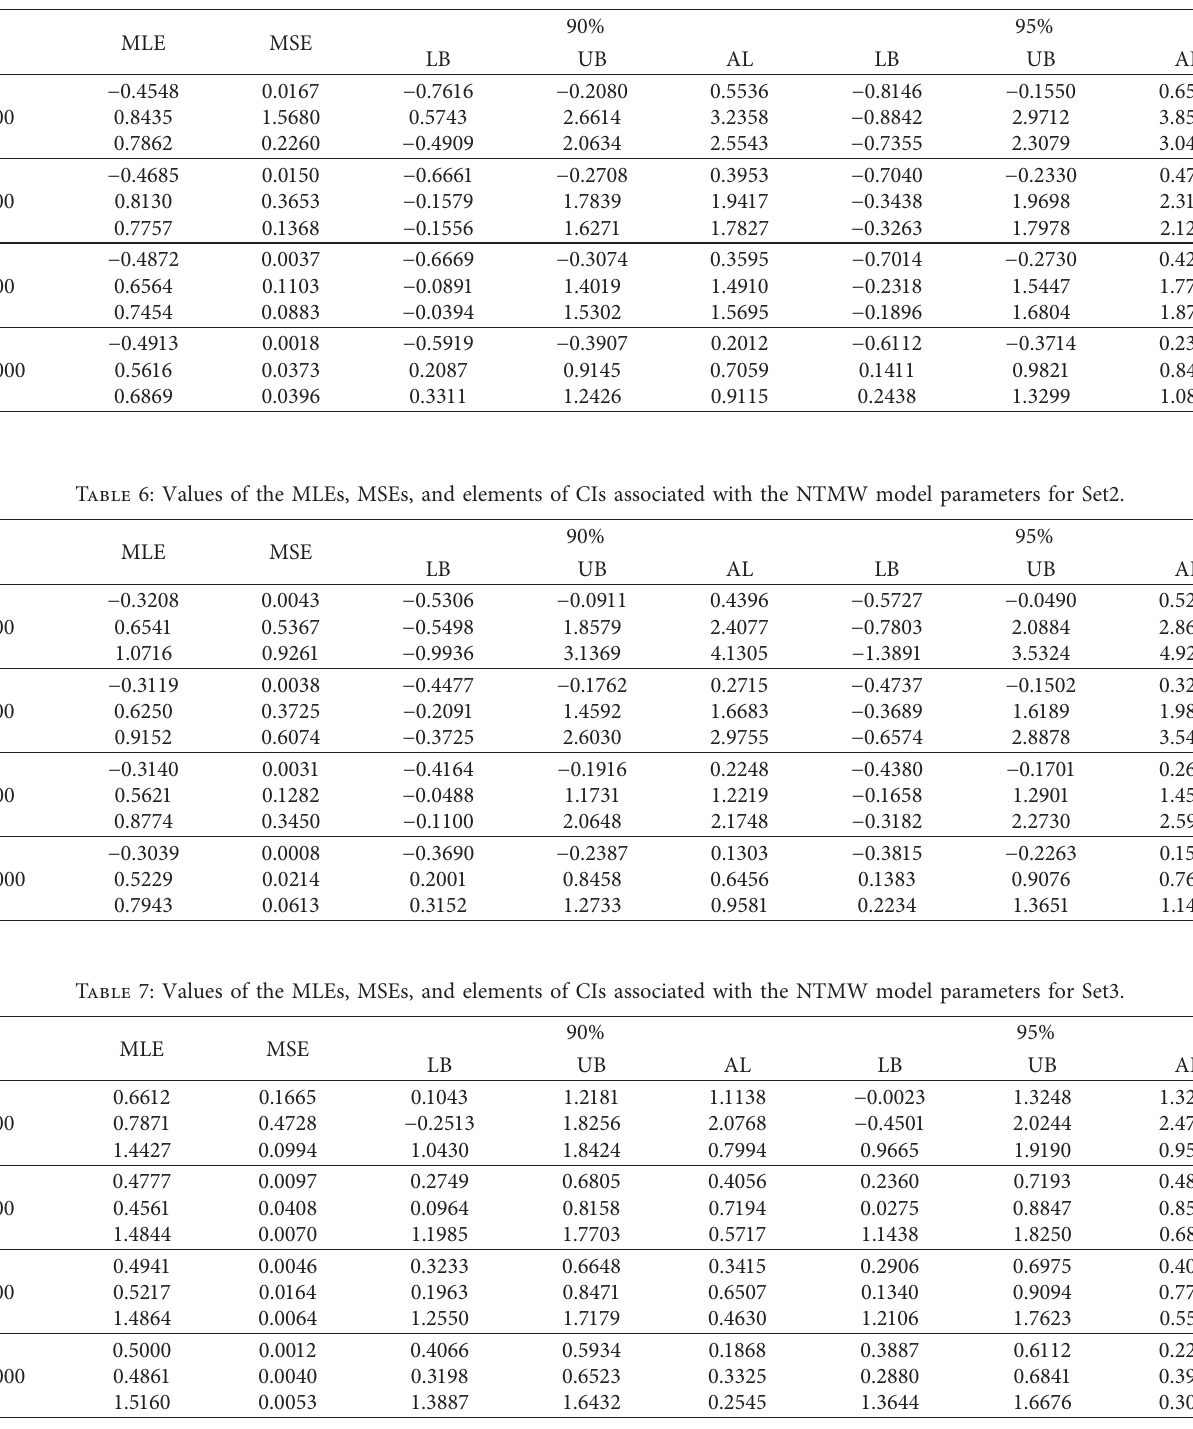
Table 5: Values of the MLEs, MSEs, and elements of CIs associated with the NTMW model parameters for Set1.